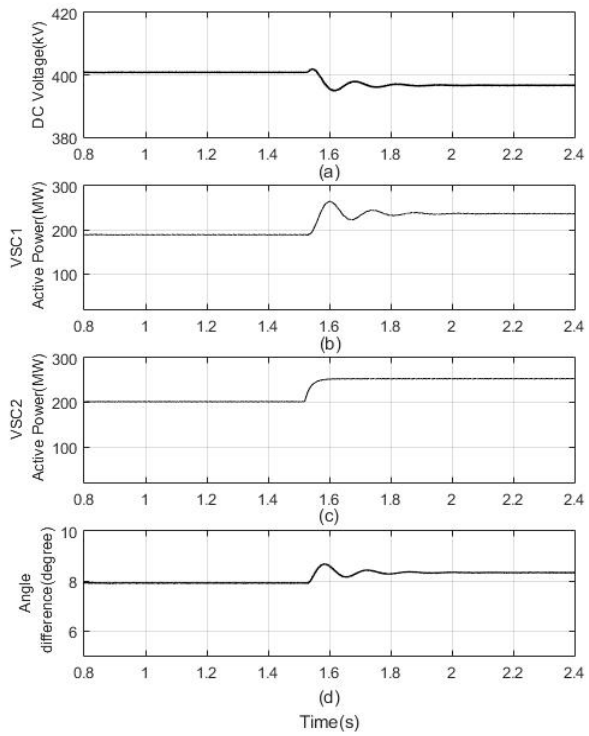
Figure 11. ATEC strategy for +(cid:2012) ° scenario ( a ) DC voltage, ( b ) VSC 1 active power, ( c ) VSC 2 active power, and ( d ) angle